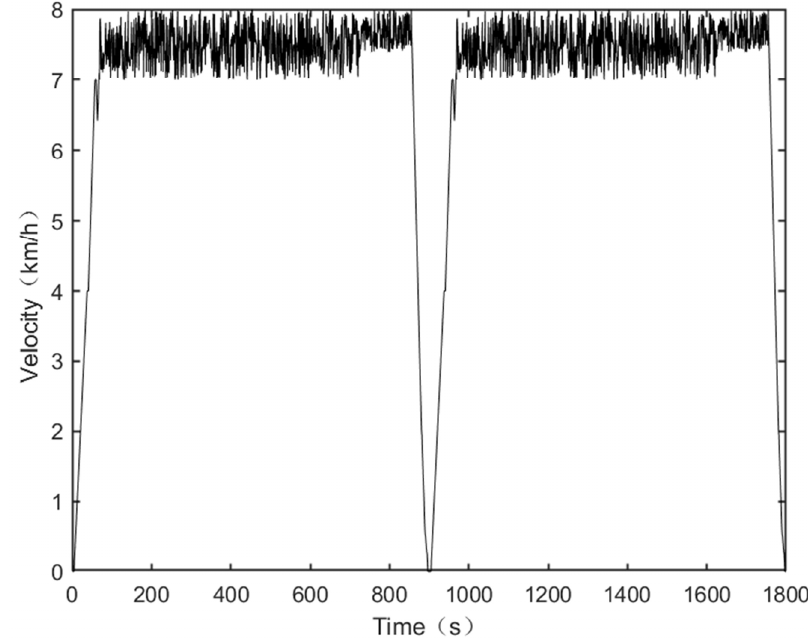
Figure 16. Plowing speed.